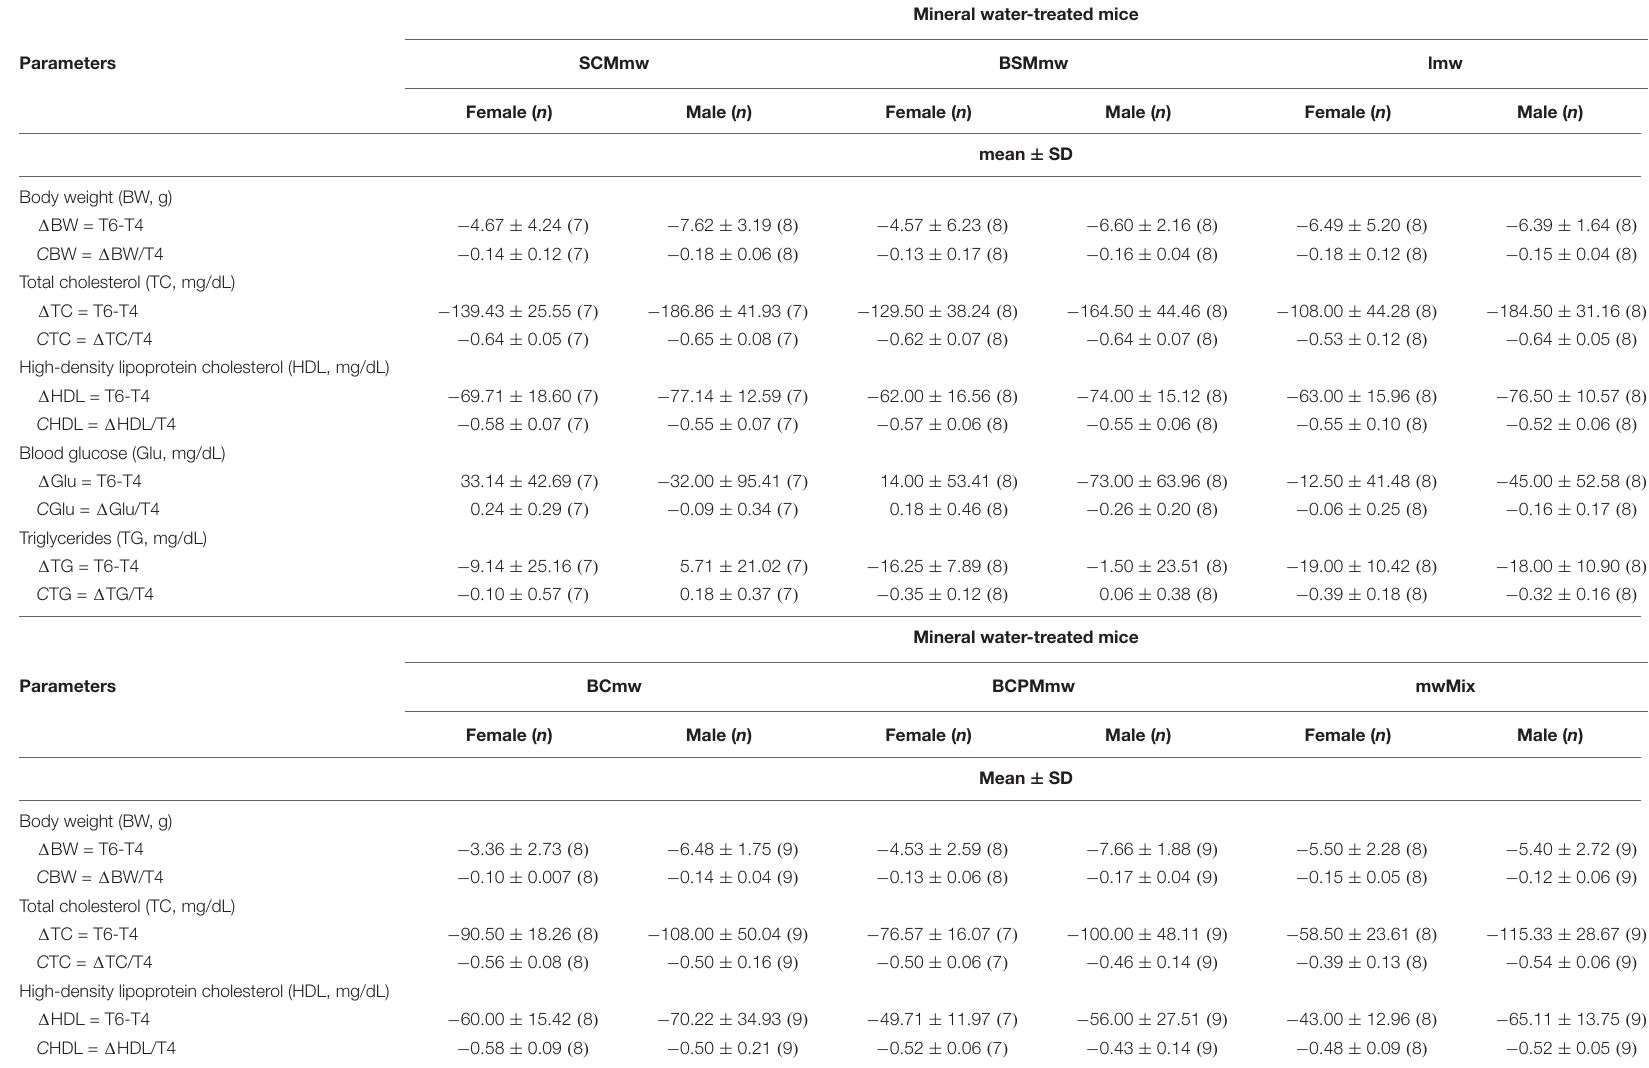
TABLE 3 | Absolute and relative changes of body weight and blood biochemical parameters of treated mice, by treatment group and gender.